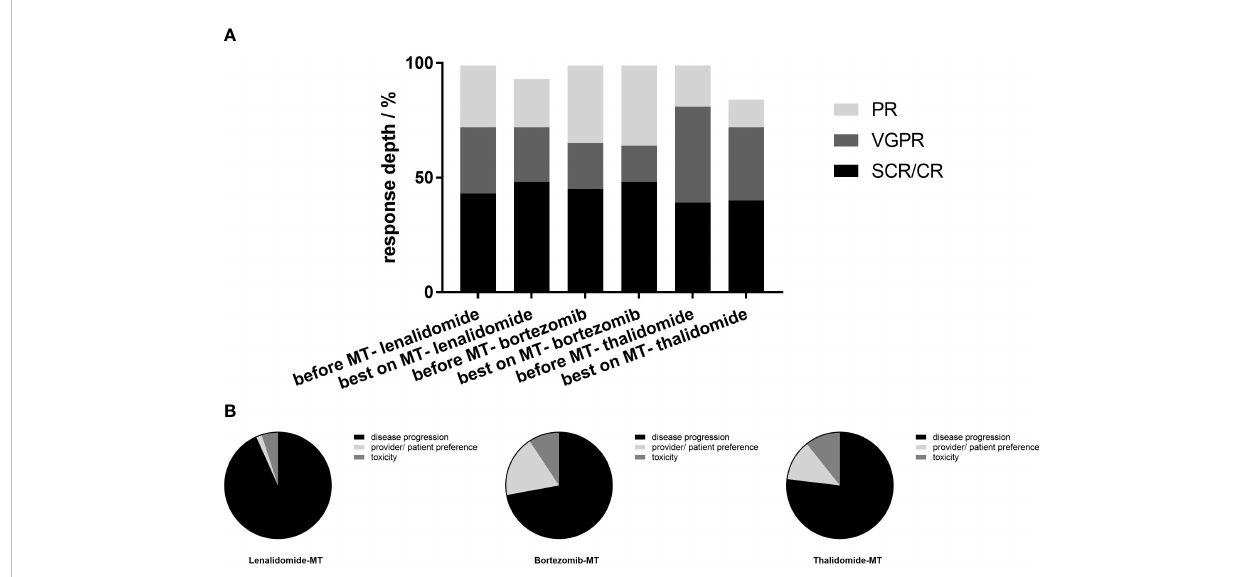
FIGURE 1 Best response before and during maintenance and reasons for discontinuing maintenance. (A) In the 141 patients on lenalidomide-MT, 61 (43.3%) achieved CR or sCR prior to the initiation of maintenance, 41 (29%) achieved VGPR, while 39(27.7%) achieved PR. In the bortezomib-MT group (n=79), 36(45.6%) achieved CR or sCR prior to the initiation of maintenance, 16 (20.3%) achieved VGPR, and 27 (34.2%) achieved PR. In the thalidomide-MT group (n=155), the ratio was 39.4% (n=61), 42.6% (n=66), and 18.0% (n=28), retrospectively. Best response on maintenance is shown in the adjacent column. On lenalidomide maintenance, 48.2% achieved CR or sCR, 24.8% achieved VGPR, and 21.3% achieved PR. In the bortezomib maintenance group, 48.1%, 16.5%, and 35.4% achieved CR or sCR, VGPR, and PR, respectively, and 40.6%, 32.3%, and 12.3% in patients on thalidomide maintenance. (B) The main reasons for discontinuing maintenance were progression (93.3%, 72.1%, and 76.9% for lenalidomide-MT, bortezomib-MT, and thalidomide-MT, respectively), provider/patient preference (1.7%, 18.6%, and 12.4%), and toxicity (5.0%, 9.3%, and